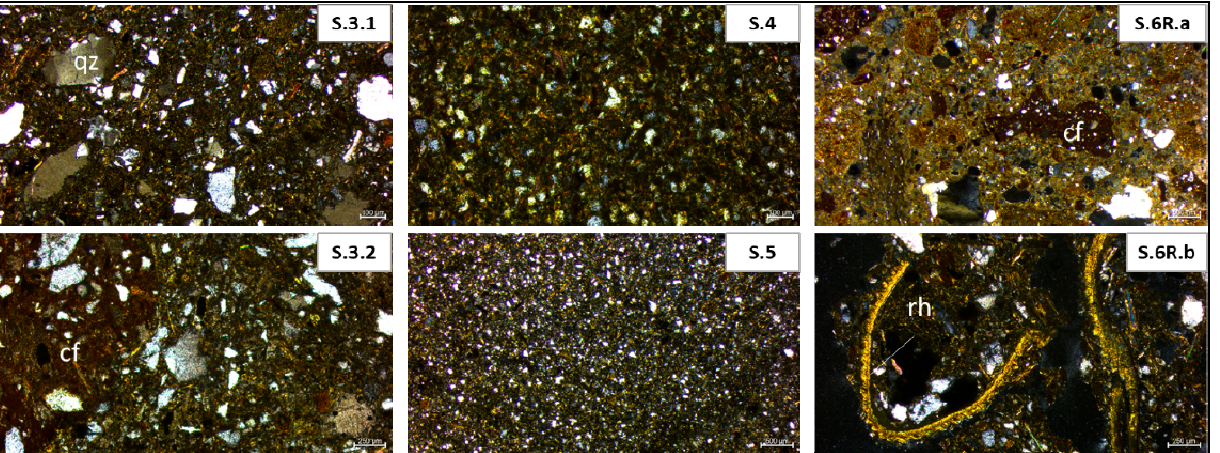
Figure 7. Optical microphotographs of the examined thin sections displaying general textural features of the samples S.3.1, S.3.2, S.4, S.5 and S.6R (S.6R.a) and detailed microphotograph (S.6R.b) of sample S.6R illustrating rice husk. qz, quartz; cf, ceramic fragment; rh, rice husk.